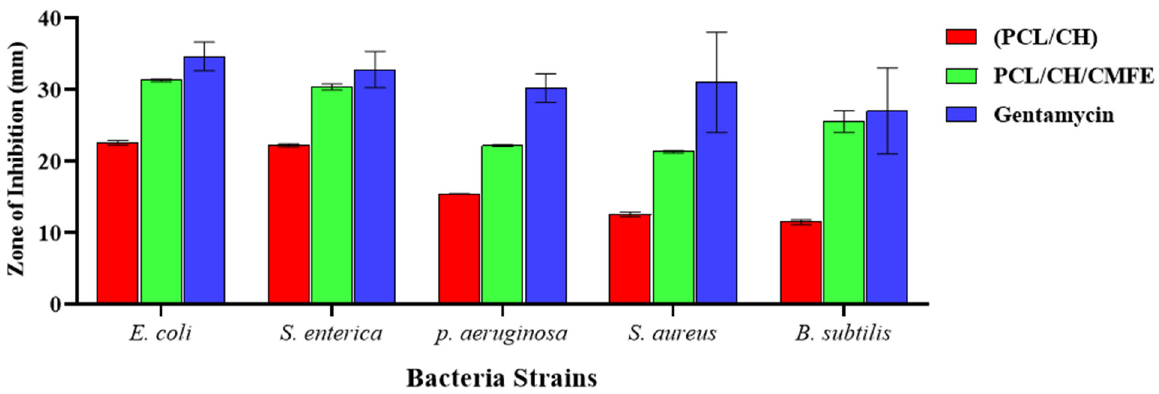
Figure 7. Antibacterial activity of PCL/CH/CMF fibrous